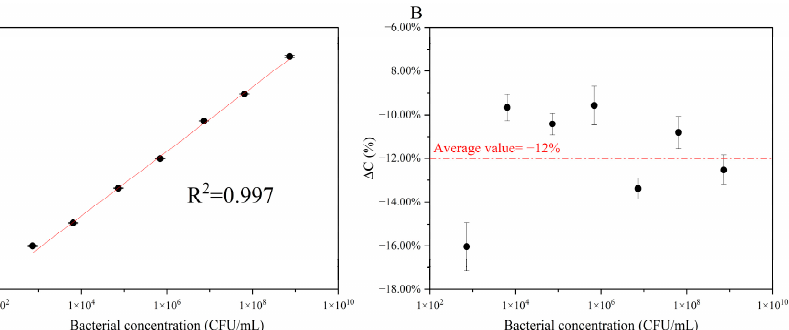
Figure 6. Changes in the bacterial concentration in the electrolyte before and after the test. The relationship between the changes in the number ( A ) and concentration ( B ) of the bacteria in the electrolyte before and after the detection and the initial concentration of E. coli .